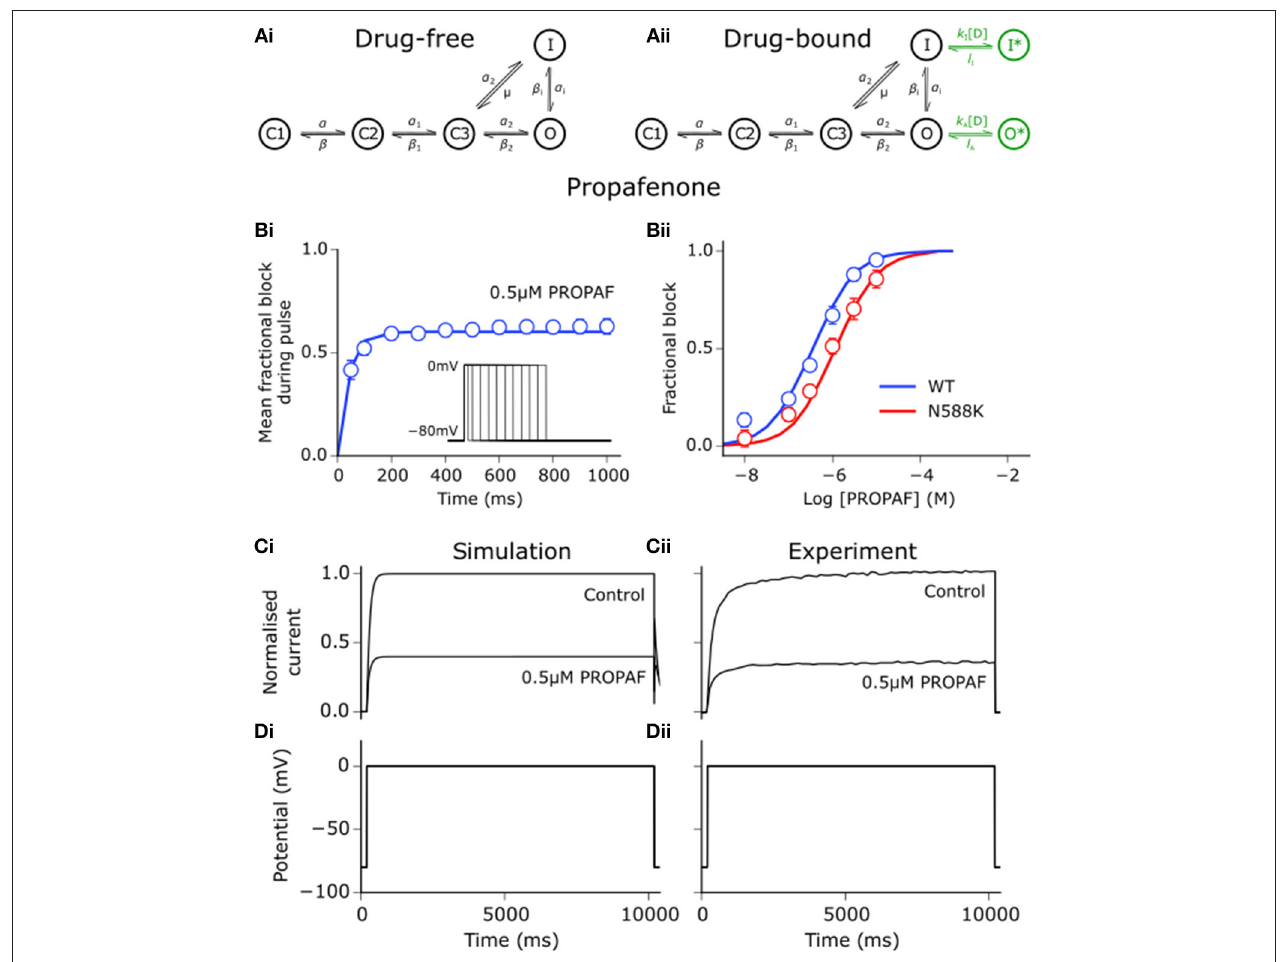
FIGURE 1 | Propafenone interactions with hERG channels. (Ai) Drug-free and (Aii) drug-bound (additional states shown in green) Markov chain models of I Kr /hERG. Simulated (solid line) and experimental (points) mean fractional block by 0.5 µ M propafenone (PROPAF) of I hERG during pulse protocol (shown inset) (Bi) , and dose-response curve under WT (blue) and SQT1 mutant N588K (red) conditions (Bii) , where IC 50 values are 390nM and 936nM (2.4-fold increase), respectively. (Ci) Simulated and (Cii) experimental current traces in response to a 10,000ms depolarising voltage step to 0mV from a holding potential of − 80mV (Di,Dii) under control conditions and with application of 0.5 µ M PROPAF – these data were used to validate and not to further train the model. Experimental data at 37 ◦ C are taken from Paul et al. (2002) and McPate et al.